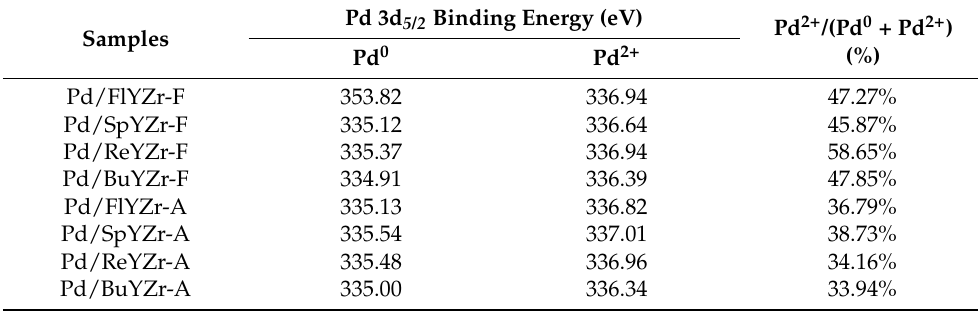
Table 3. Pd 3d XPS data of Pd/Y-ZrO 2 catalysts with different morphologies.